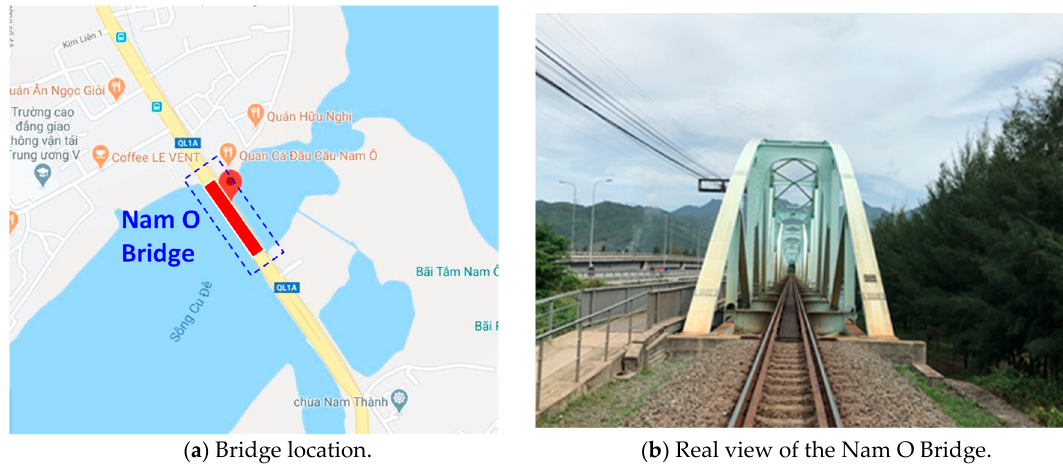
Figure 13. The Nam O Bridge in Da Nang (Vietnam) as a test structure.